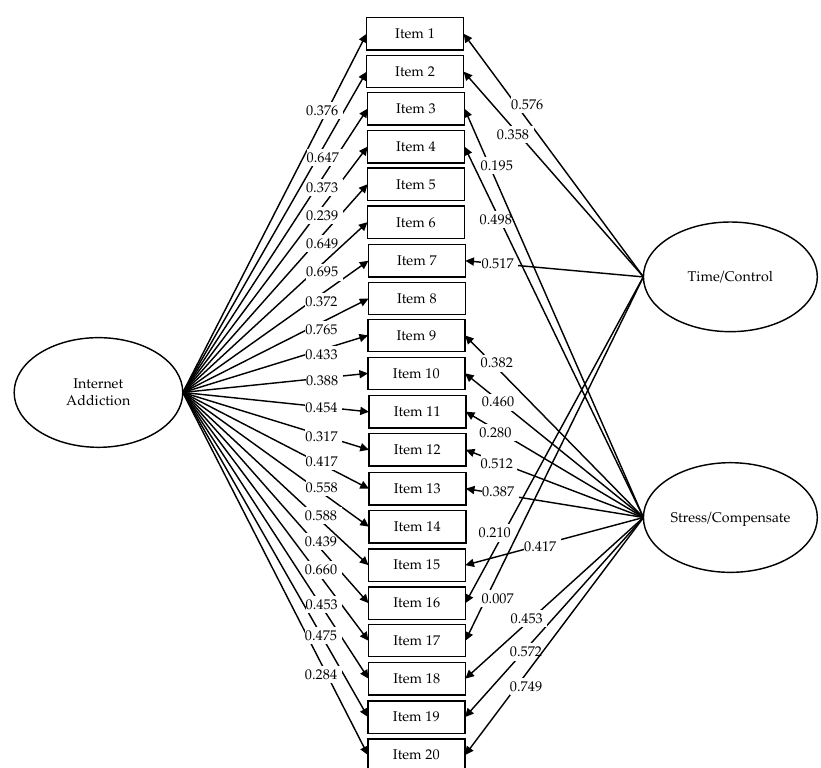
Figure 2. Factorial structure of the bifactor model.